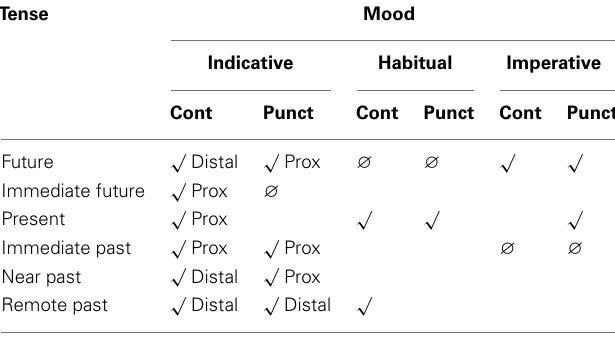
Table 4 |The limited overlap between spatial and temporal